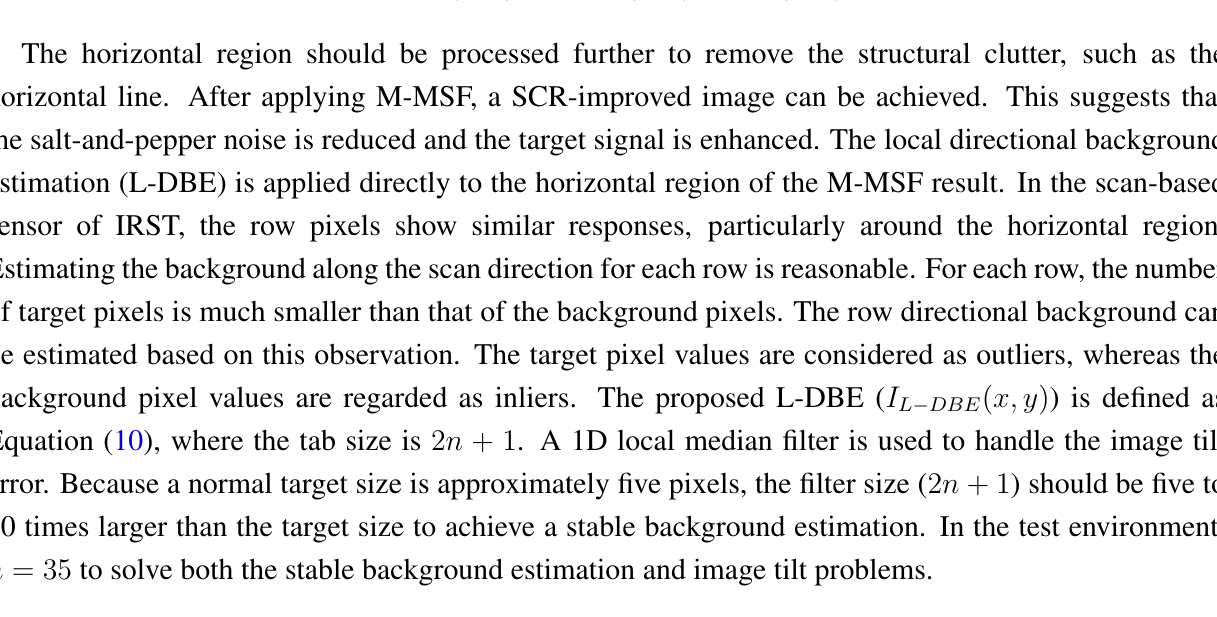
Proposed small target detection and horizontal line clutter removal in the horizon